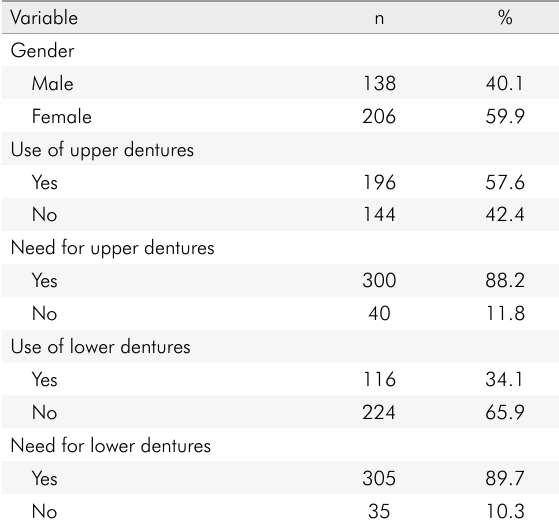
Table 1. Distribution of the participants of the study regarding gender and the use of and need for removable dentures.